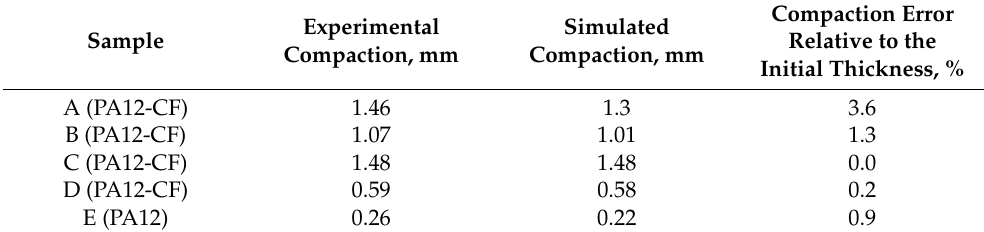
Table 6. Measured and simulated final sample compaction.